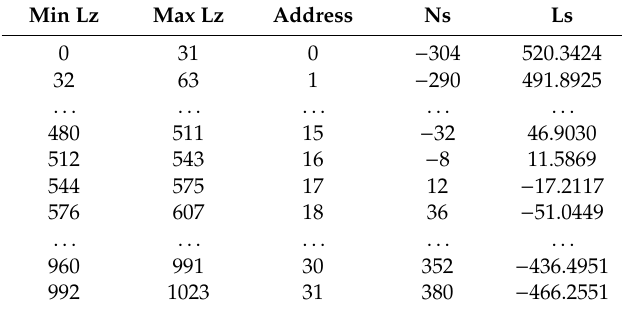
Table 3. Look-up table LUT1LS for 32 sectors.